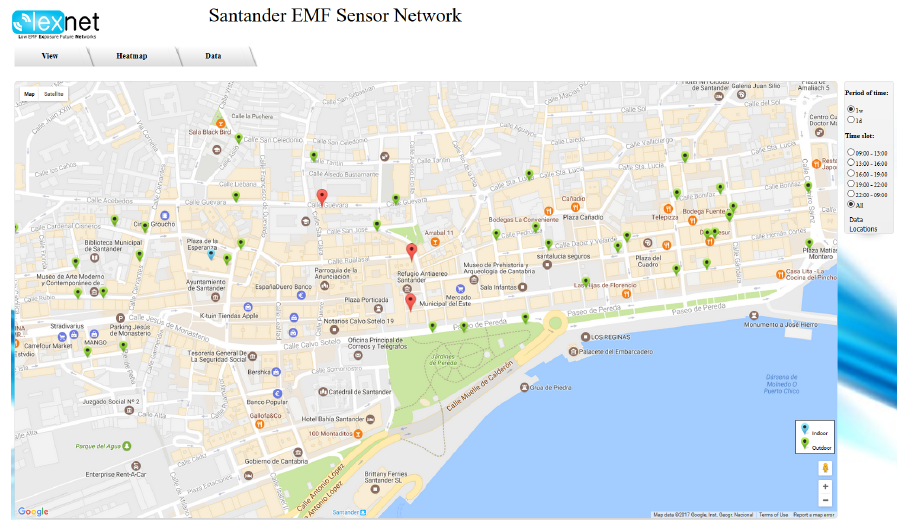
Figure 8. Dosimeter selection for data retrieval.